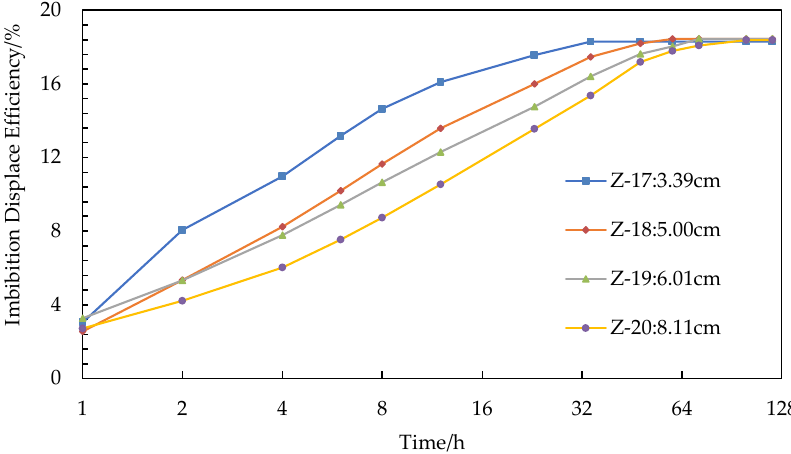
Figure 3. Displacement efficiency curve of imbibition for investigating the core length.